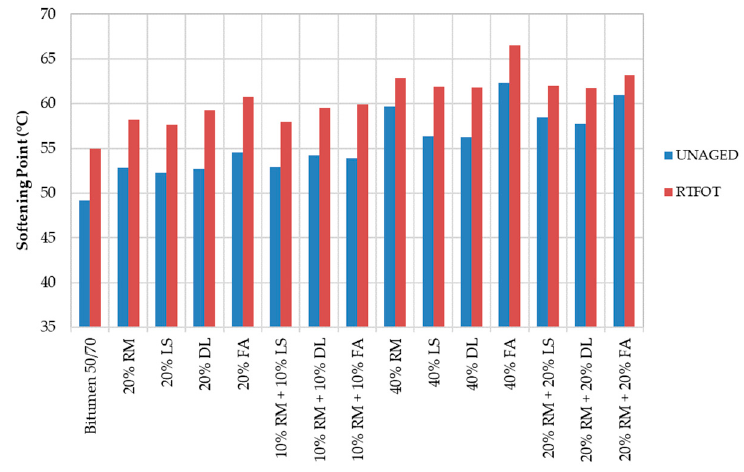
Figure 4. Softening point of mastics before and after RTFOT.